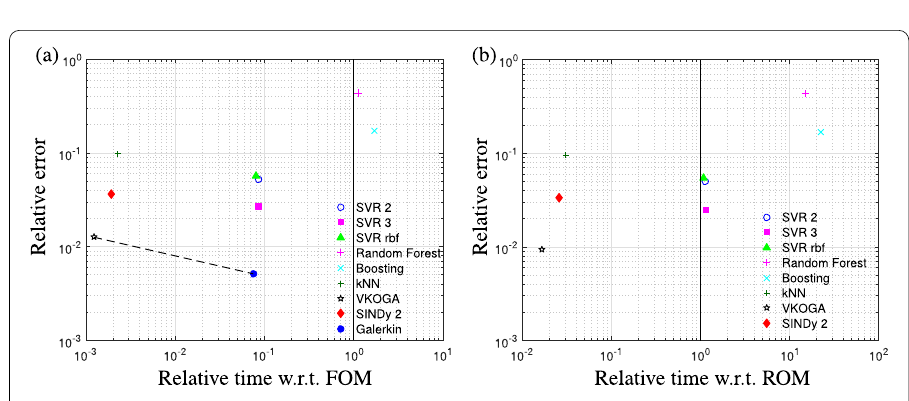
Fig. 9 Pareto frontier of relative error with respect to the relative running time using backward Euler for 2D convection–diffusion equation: a e FOM vs. τ FOM in FOM; b e ROM vs. τ ROM in ROM